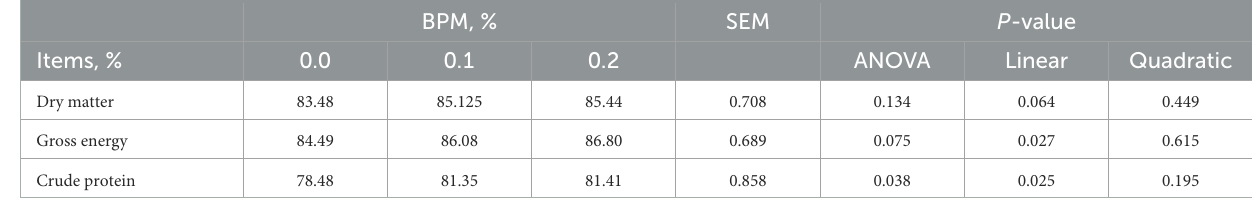
TABLE 4 Effect of dietary supplementation of Bacillus subtilis and Pichia farinose mixture (BPM) on apparent ileal digestibility of broiler chicks ∗ . BPM, % SEM P -value Items, %